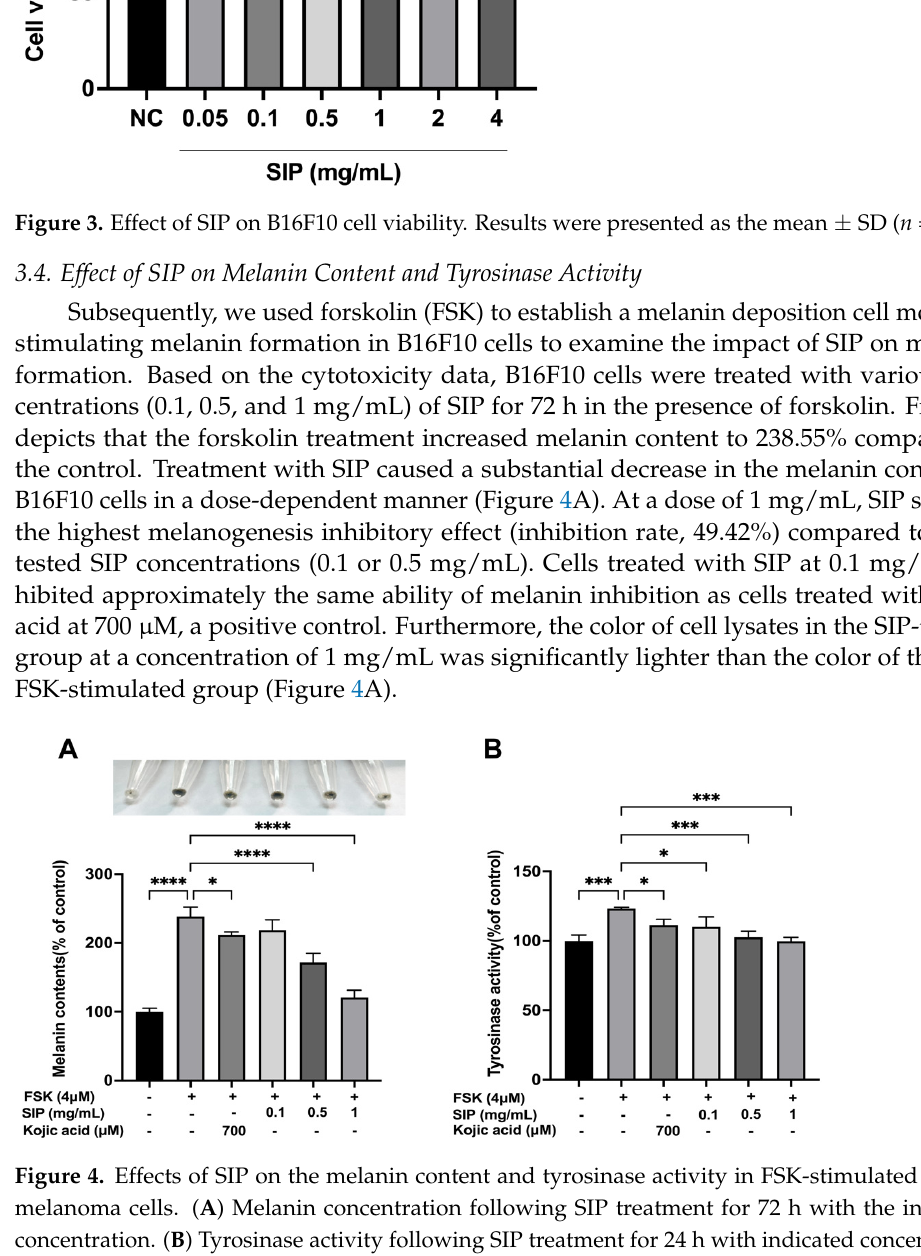
Figure 4. Effects of SIP on the melanin content and tyrosinase activity in FSK-stimulated B16F10 melanoma cells. ( A ) Melanin concentration following SIP treatment for 72 h with the indicated con- centration. ( B ) Tyrosinase activity following SIP treatment for 24 h with indicated concentration. Results were presented as the mean ± SD. Statistical analysis was performed with one-way ANOVA, followed by Tukey’s multiple comparison test ( n = 3; * p < 0.05, *** p < 0.001, and **** p < 0.0001 compared with the forskolin-stimulated group).